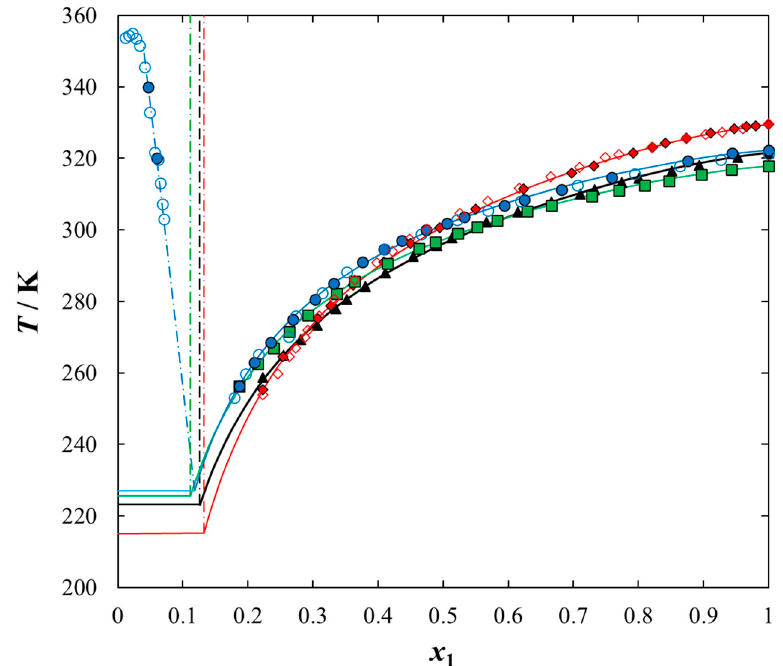
Figure 2. Experimental and calculated (solid + liquid), SLE and (liquid + liquid), LLE phase equilibrium data for {IL (1) + thiophene (2)} binary system: ♦ , [BQuin][NTf 2 ]; ◊ , [BQuin] [NTf 2 ] [18]; ▲ , [BiQuin][NTf 2 ]; ■ , [HQuin][NTf 2 ]; ● , [OQuin][NTf 2 ]; ○ , [OQuin][NTf 2 ] [22]. Points show the experimental data; solid line is thee correlation of NRTL model with parameters given in Table 5; dash-dotted line is the experimental binodal curve.